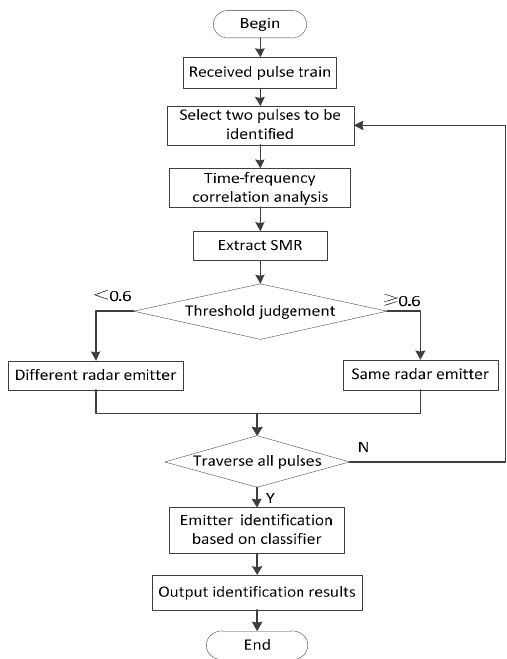
Figure 7. Sketch map of using SMR in radar emitter identification